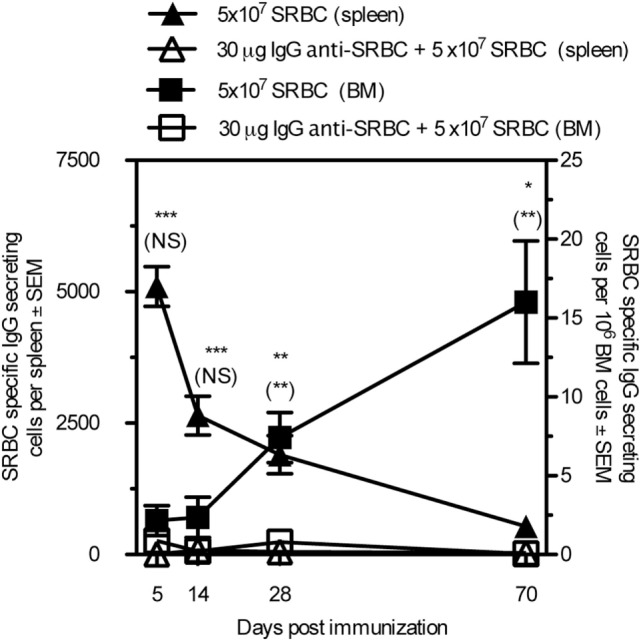
IgG suppresses the generation of long-lived plasma cells. BALB/c mice were immunized with 5 × 107 sheep red blood cell (SRBC) ± 30 μg IgGb anti-SRBC. Spleens and bone marrow were harvested and SRBC-specific antibody-secreting cells were measured with ELISPOT. Comparisons between filled and open triangles are given without parentheses and comparisons between filled and open squares are given within parentheses. ns, p > 0.05; *p < 0.05; **p < 0.01; ***p < 0.001.